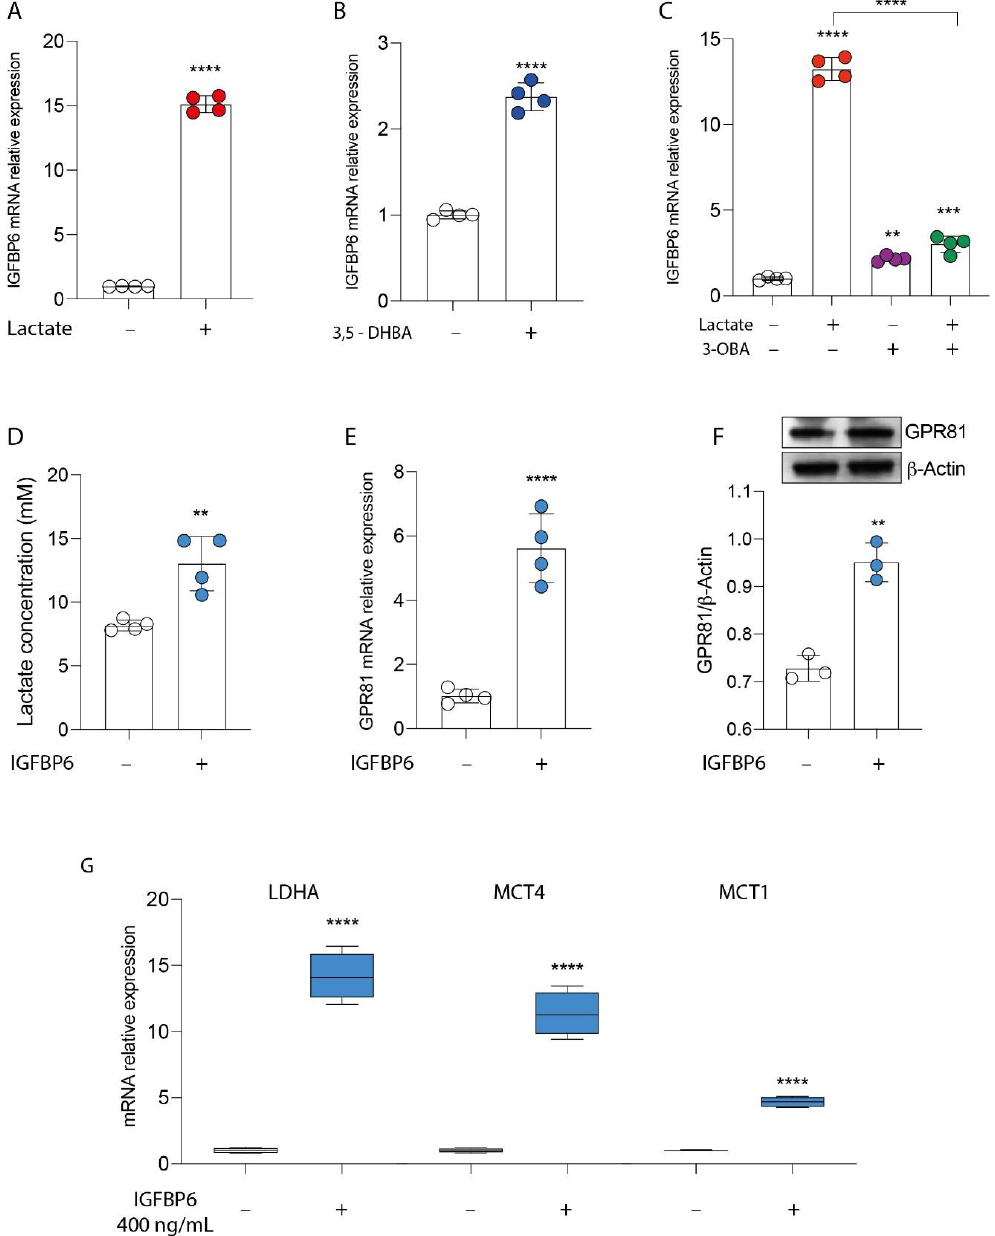
Figure 3. GPR81/IGFBP6 axis in breast cancer cells. Effect of lactate (20 mM) ( A ), 3,5-DHBA (150 μM) ( B ) and 3-OBA (3 mM) ( C ) on IGFBP6 mRNA expression levels, following 24 h of treatment. Effect of IGFBP6 treatment (800 ng/mL) on lactate production ( D ), GPR81 mRNA expression levels ( E ) and GPR81 protein expression ( F ), following 24 h of treatment. Evaluation of relative mRNA expression levels of LDHA, MCT4 and MCT1 ( G ) in IGFBP6-exposed (400 ng/mL) cells. The calculated value of 2 - ΔΔCt in untreated controls is 1. Data are expressed as mean ± SD of at least four independent experiments. ** p < 0.005; *** p < 0.001; **** p < 0.0001.